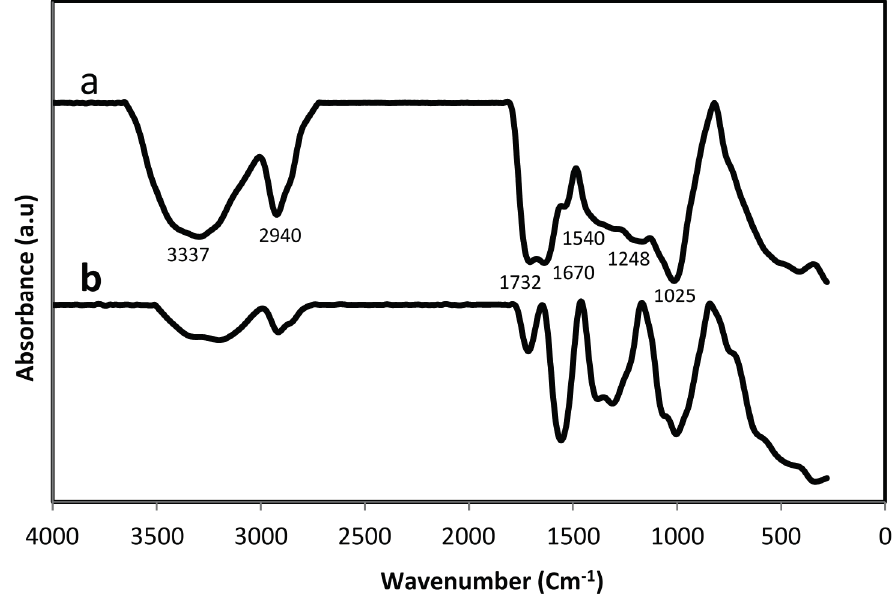
Figure 6. FTIR spectra of sumac before ( a ) and after ( b ) synthesis of